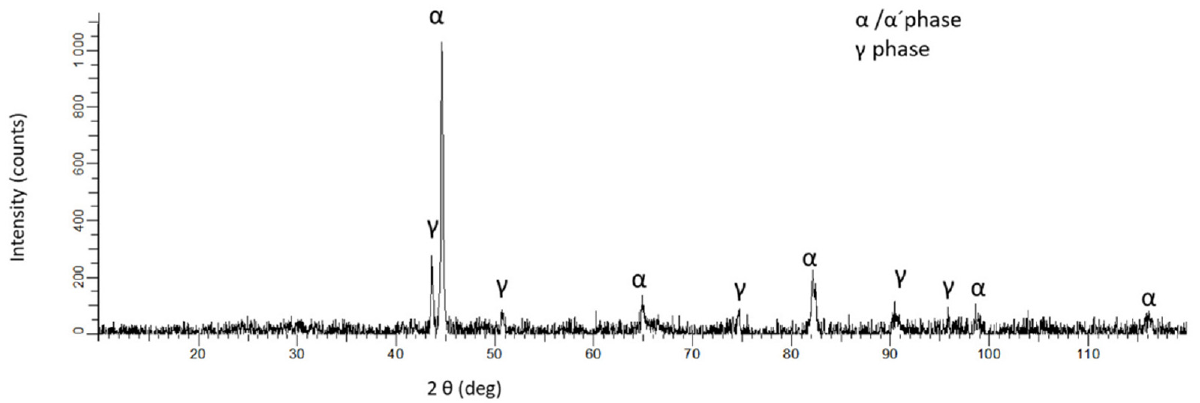
Figure 2. X-ray diffraction pattern of the 17-4PH starting powder.